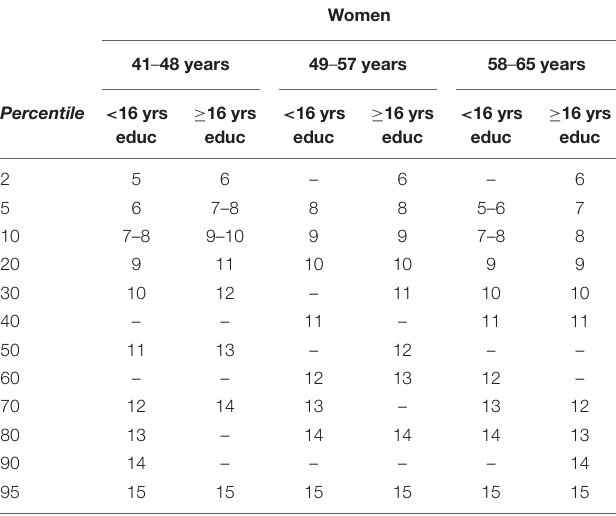
TABLE 8 | Normative data for women performance on RAVLT Delayed Recall.